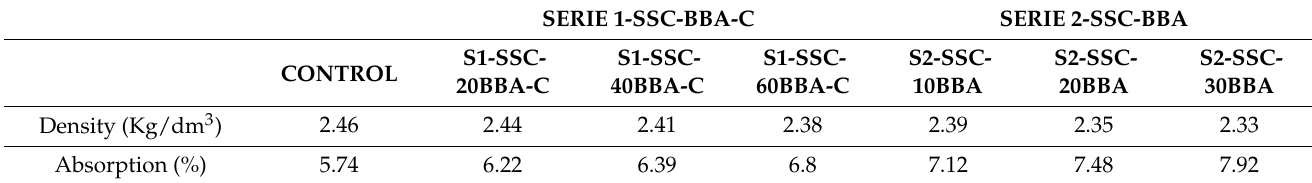
Table 7. Density and absorption of hardened